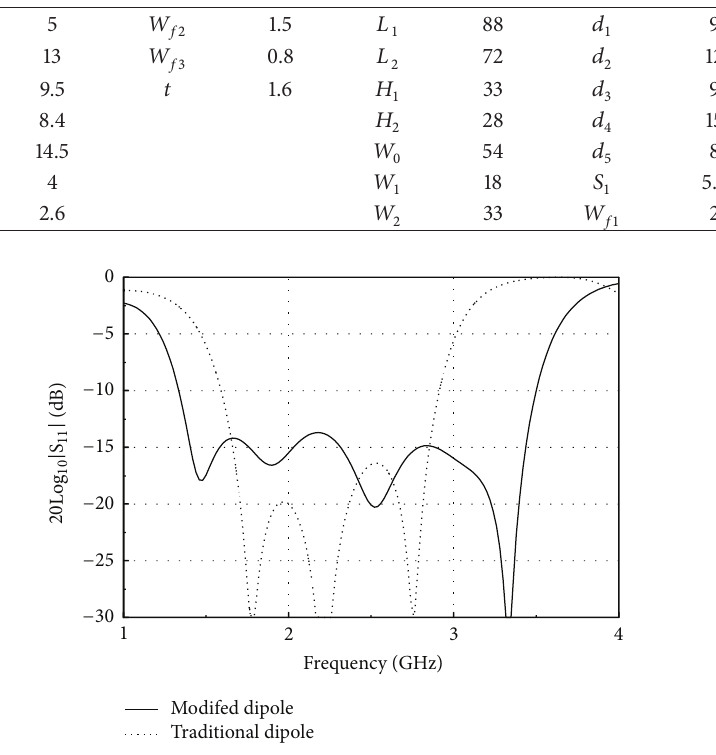
Figure 2: Simulated reflection